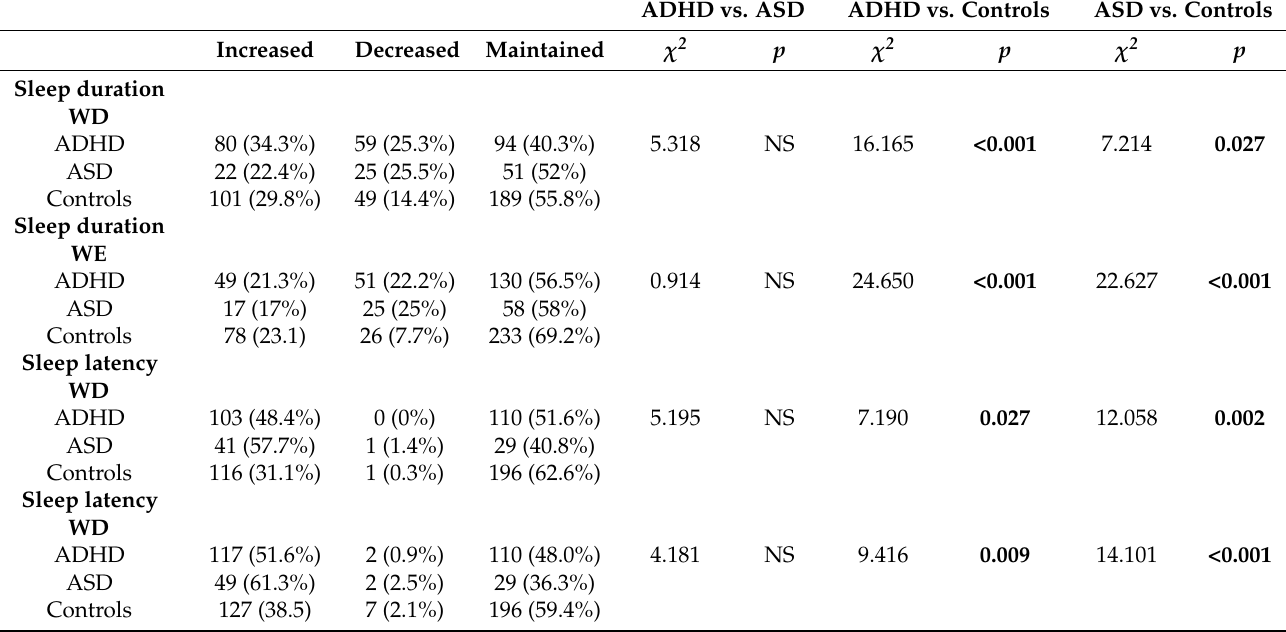
Table 6. Comparison of weekday–weekend sleep duration and sleep latency in the three groups. ADHD vs. ASD ADHD vs.